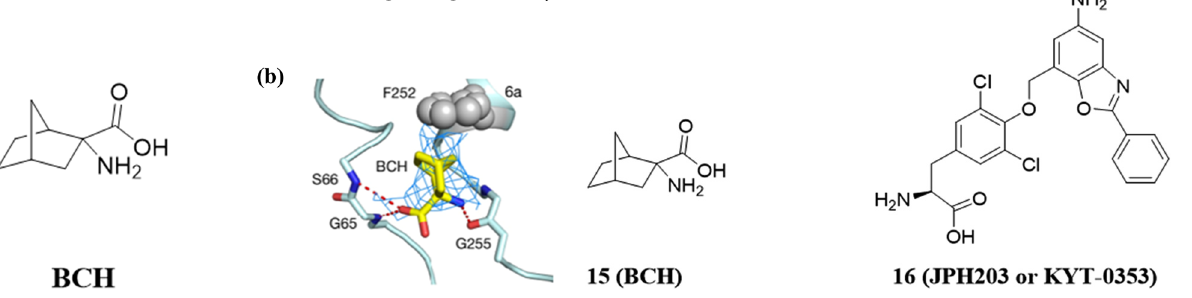
Figure 8: Chemical structures of inhibitor 15 ( BCH ) and inhibitor 16 ( JPH 203 )